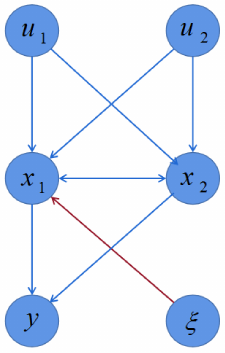
Figure 4. Network diagram of system (29).